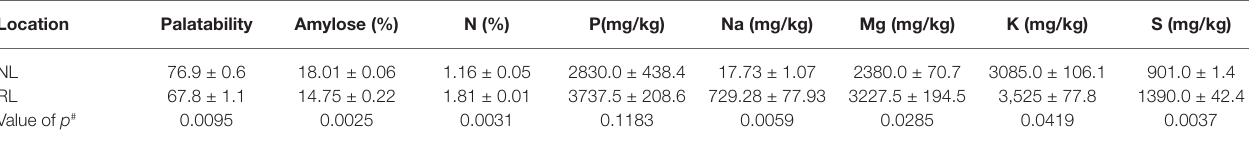
Data represent mean ± SD. # The value of p for each chemical property was determined by analysis of t-test between NL and